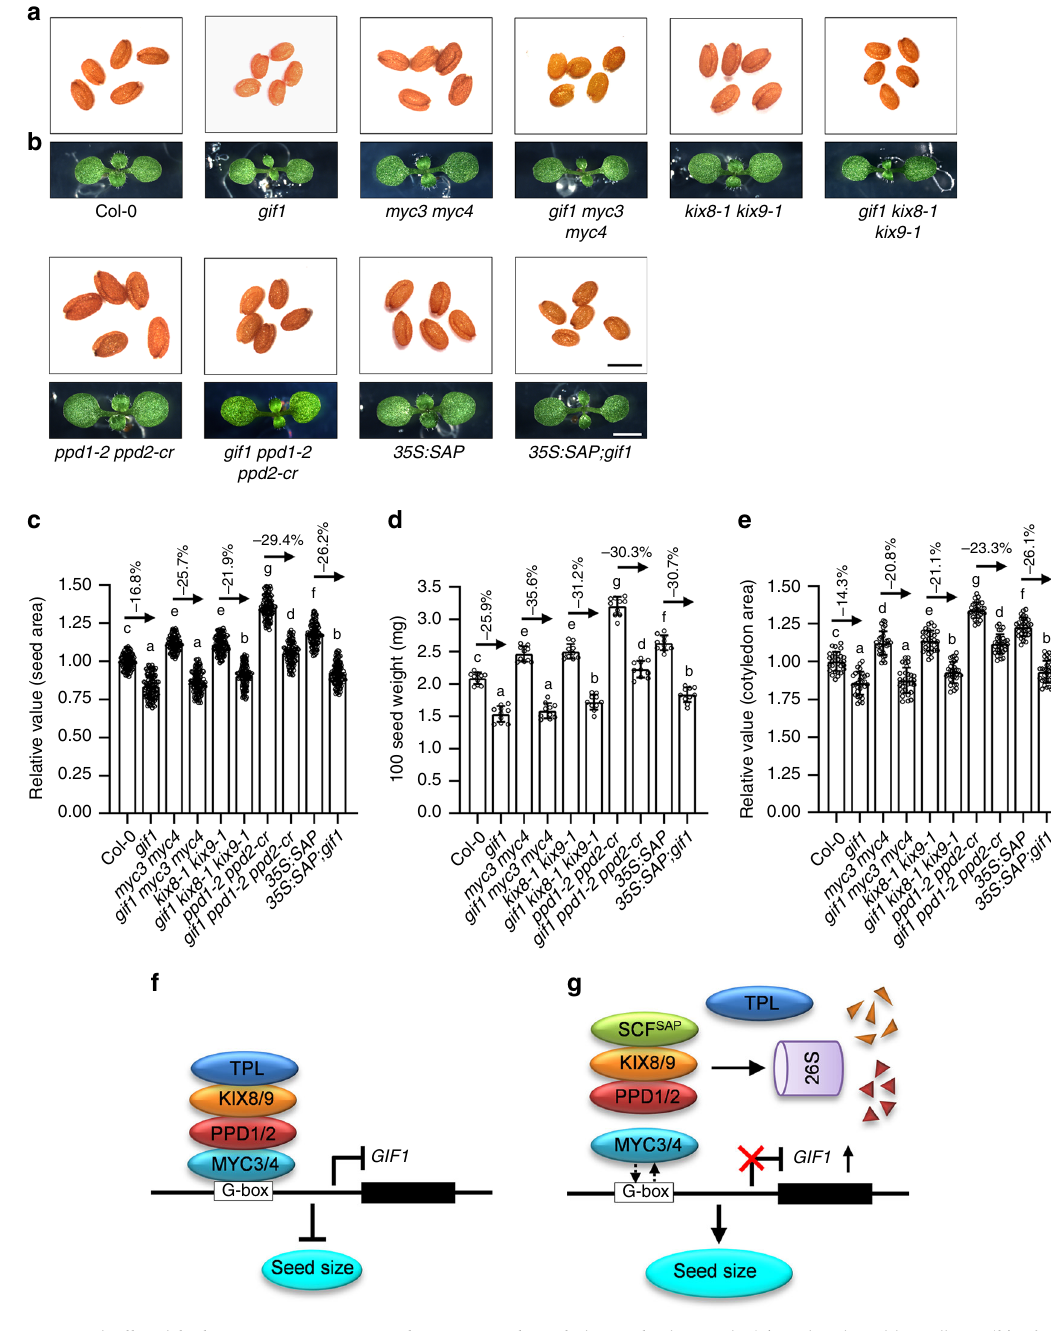
Fig. 7 GIF1 acts genetically with the KIX-PPD-MYC complex to control seed size. a , b The seeds ( a ) and 8-day-old seedlings ( b ) of Col-0, gif1 , myc3 myc4 , gif1 myc3 myc4 , kix8 - 1 kix9 - 1 , gif1 kix8 - 1 kix9 - 1 , ppd1 - 2 ppd2 - cr , gif1 ppd1 - 2 ppd2 - cr , 35S : SAP , and 35S:SAP ; gif1 plants. c – e The relative seed area ( c , n = 100), 100 seed weight ( d , n = 10), and cotyledon area ( e , n = 30) of Col-0, gif1 , myc3 myc4 , gif1 myc3 myc4 , kix8 - 1 kix9 - 1 , gif1 kix8 - 1 kix9 - 1 , ppd1 - 2 ppd2 - cr , gif1 ppd1 - 2 ppd2 - cr , 35S : SAP , and 35S:SAP ; gif1 plants. f The TPL-KIX-PPD-MYC complex associates with the G-box sequence of GIF1 promoter and represses its expression. g The transcriptional repression of GIF1 is relieved by SAP modulating the KIX-PPD module for 26S proteasome degradation. Without the KIX- PPD complex, the binding ability of MYC3/4 with the promoter of GIF1 is decreased and the GIF1 expression is increased. Seeds from the third to seventh silique on the stem of six plants were used for analysis. Cotyledons from the 8-day-old seedlings were used for analysis. Scale bars, 0.5 mm ( a ) and 0.2 cm ( b ). Error bars represent ±SE. Different lowercase letters above the columns indicate the signi fi cant difference among different groups, one-way ANOVA P -values: P <